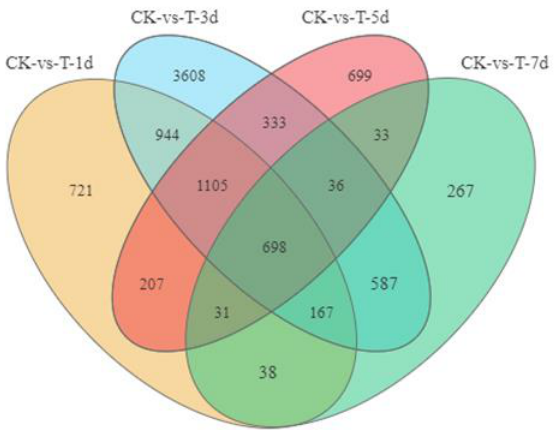
Figure 3. Venn diagram of differentially expressed genes after high-density treatment.